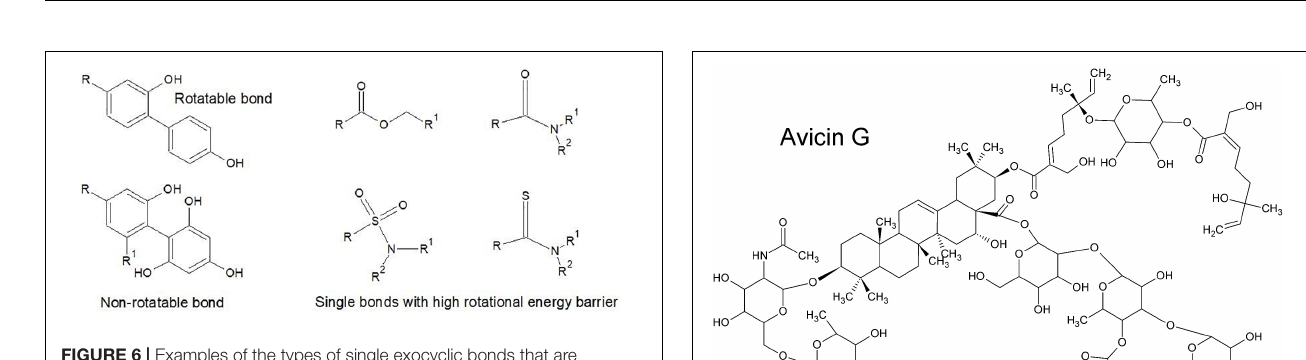
FIGURE 6 | Examples of the types of single exocyclic bonds that are excluded as rotatable bonds due to high rotational energy barrier. In the case of the Ar-Ar bonds, substitution at the ortho positions creates a rotational energy barrier. The S-N and C-N bonds of amides and the C-O bond in esters also have energy barriers against rotation in normal physiological conditions.